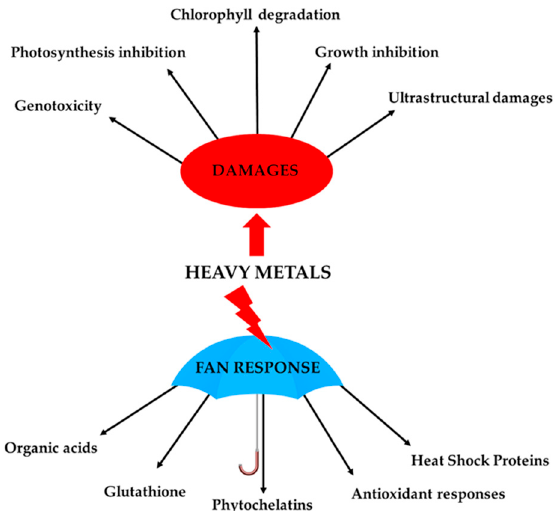
Figure 1. Schematic figure of cellular responses and alterations caused by heavy metals in bryo- phytes.